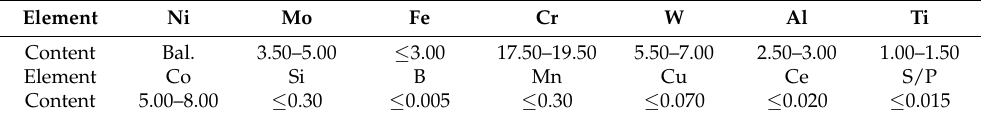
Table 2. Nominal composition of GH4099 (wt.%).